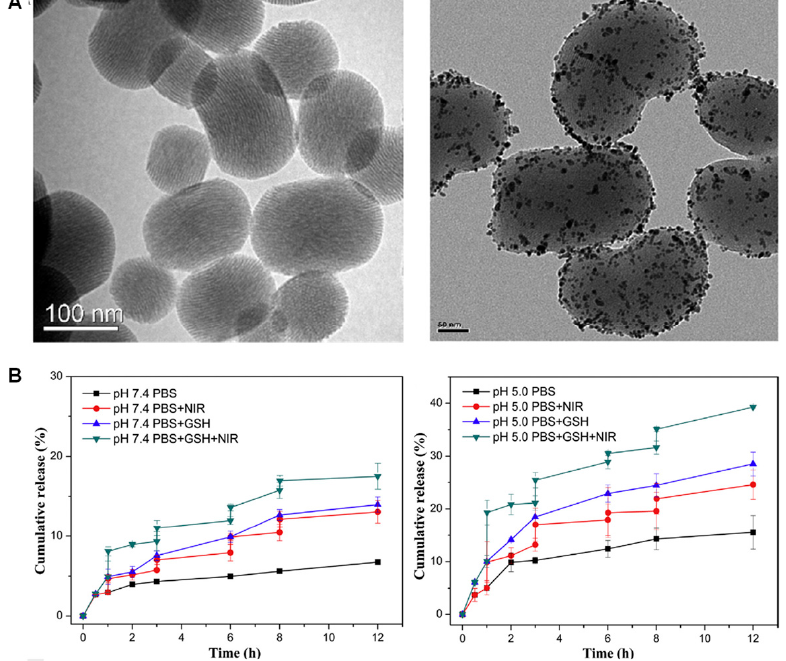
Figure 4. ( A ) TEM micrographs of MSNs and MSNs coated with Au NPs. ( B ) Release profiles at different pHs, in the presence or absence of GSH, and upon application or not of NIR light. The highest drug release is obtained when both GSH and NIR light are applied. Adapted with permission from [30]. Copyright Elsevier,